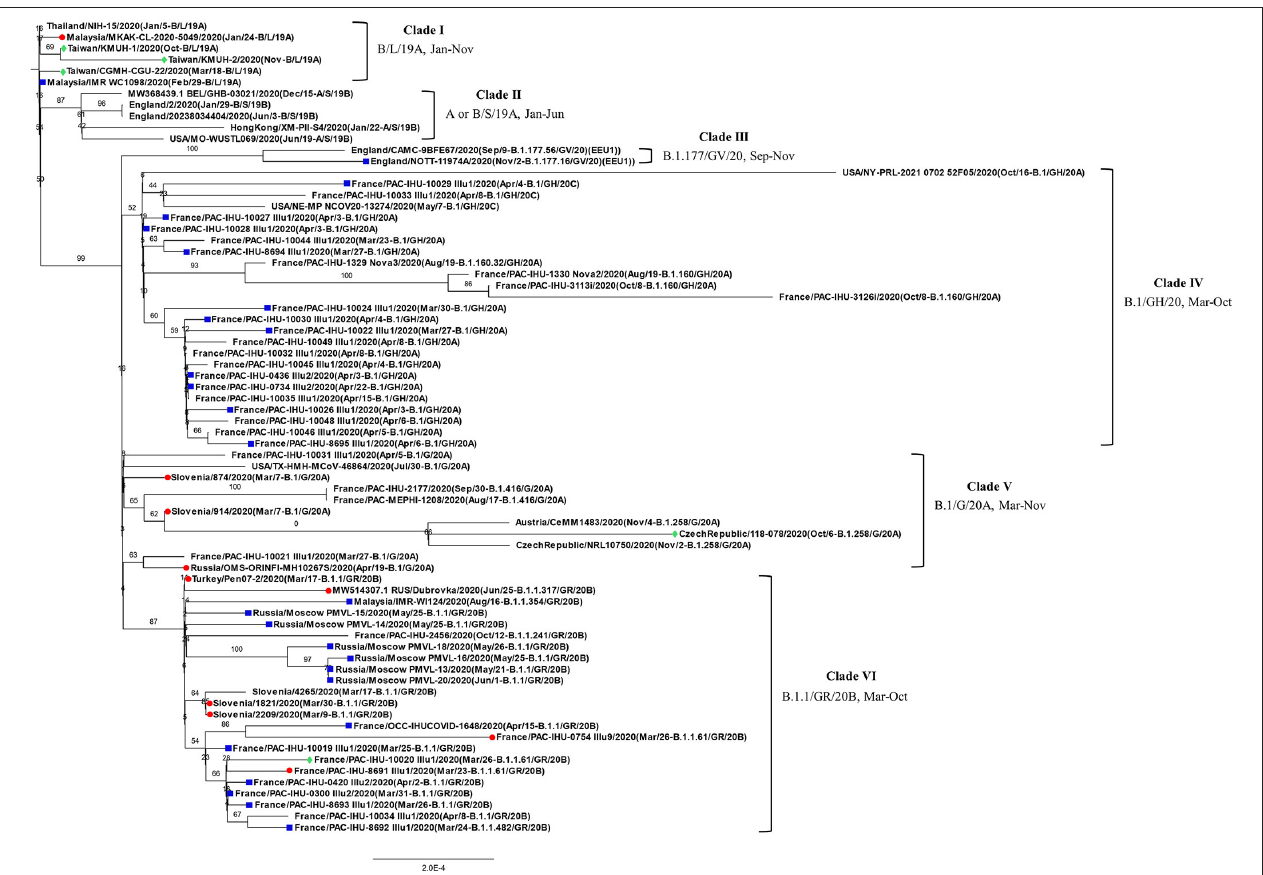
FIGURE 2 | Phylogenetic analysis of 72 closely related SARS-CoV-2 genomes by the maximum likelihood method. The phylogenetic analysis was inferred by using the maximum likelihood method using TIM2 + F + I as the best fitted model with the lowest Baysian information criterion (BIC) scores. An original tree was displayed using FigTree v1.4.4 with bootstrap values and a scale bar. The viruses are shown as the virus name (GISAIG) or accession number (GenBank)/sample collection year (date/pangolin_lineage/GISAID_clade/nextstrain_clade). •: Spike 68-76del; (cid:4) : Spike 675-679del; (cid:7) Spike 68-76del + Spike 675-679del double